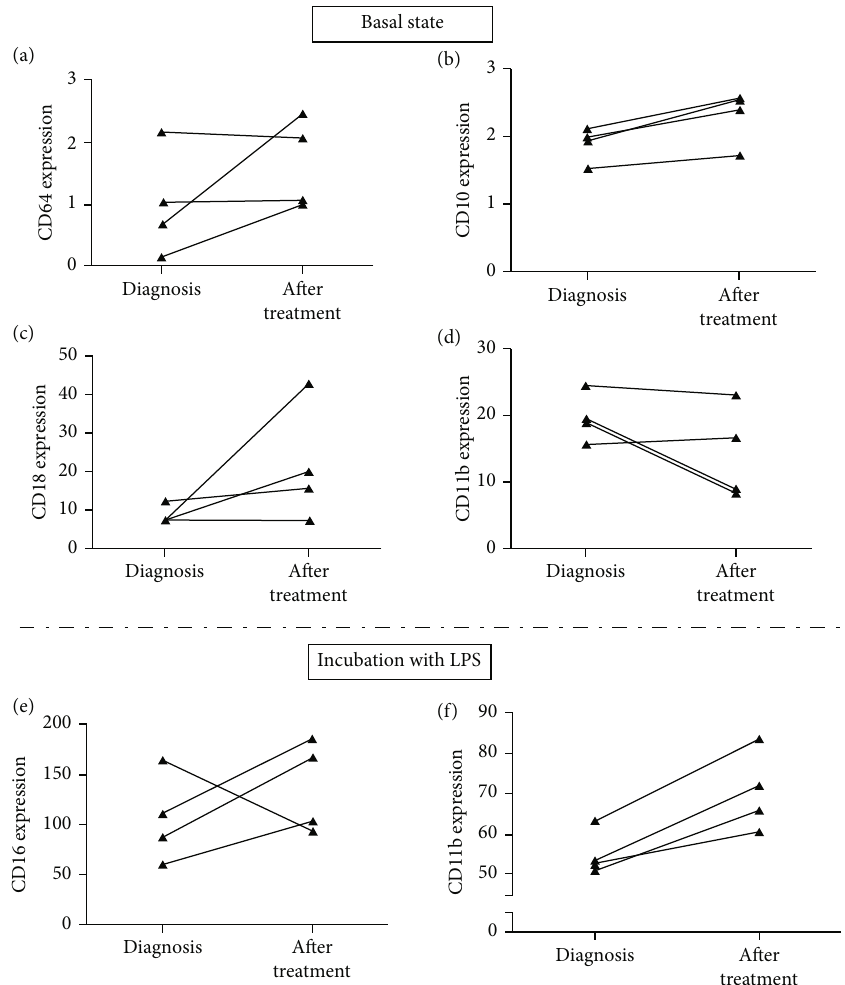
Figure 3: The intensity of expression of surface markers on PMN in four PAD patients before and after (5-7 months) the initiation of immunoglobulin replacement treatment. (a) CD64, (b) CD10, (c) CD18, and (d) CD11b at basal state and (e) CD16 and (f) CD11b after whole-blood incubation with LPS. Each line in the plot corresponds to data of each